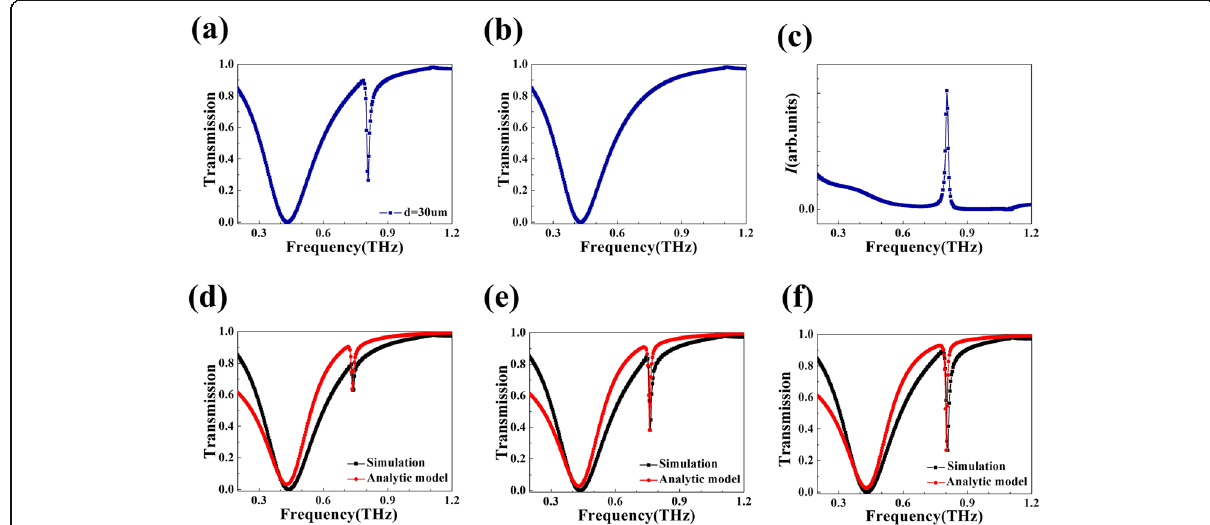
Fig. 2 a Transmittance curve of the designed metasurface given by numerical simulation. b Transmission spectrum of the bright mode. c Field intensity of the proposed four-strip nanostructure illuminated by a dipole source. d , e , f Simulated (red curve) and theoretical (black curve)